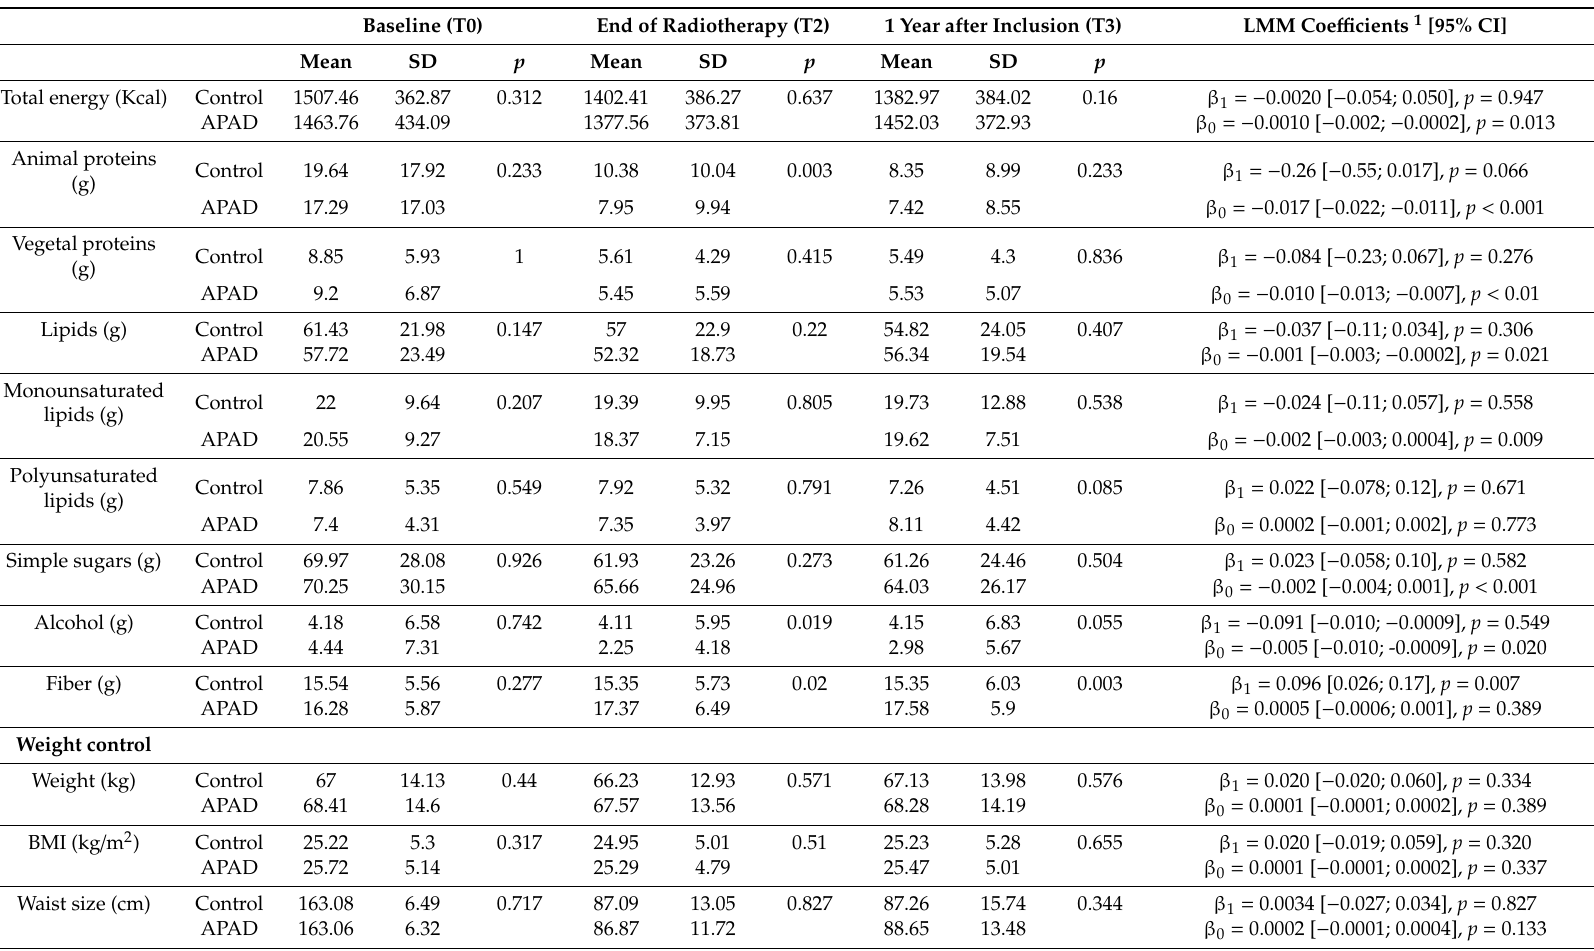
Table 6. Dietary intake per day (3-day record) and weight control variables in the intention-to-treat